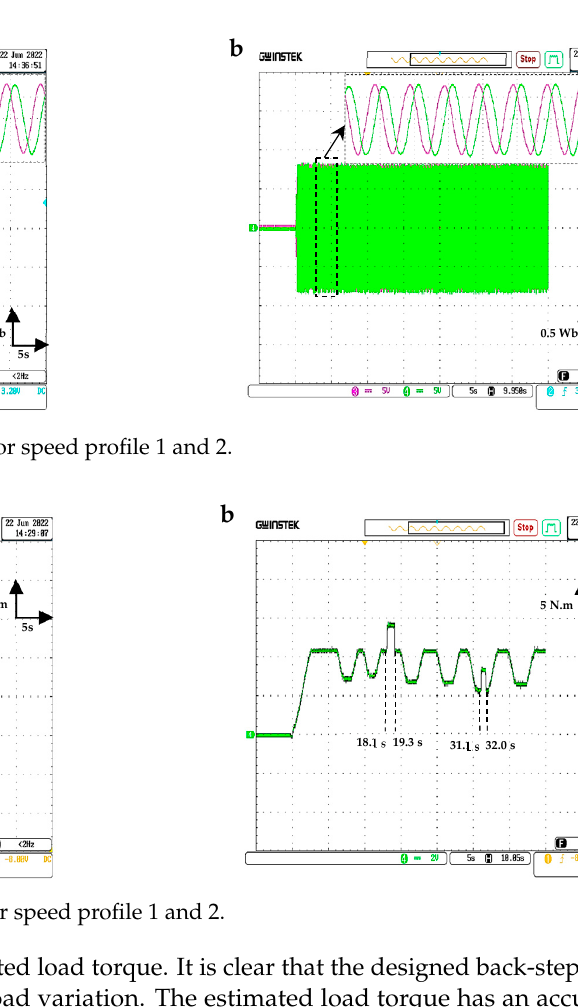
Figure 24. Estimated load torque for speed profile 1 and 2. Table 3. Benefits of speed planning algorithm and back ‐ stepping approach.